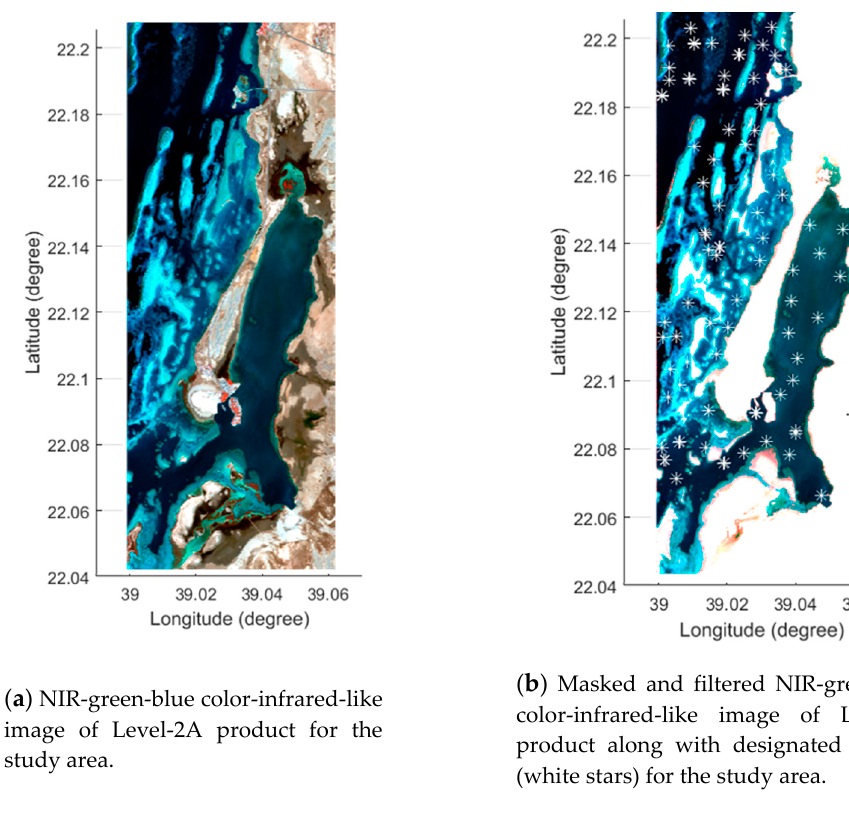
Figure 5. NIR-green-blue color-infrared-like images of original, masked, and filtered Level-2A product along with designated stations (white stars) for the study area.